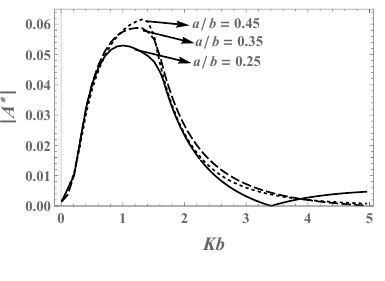
Figure 7. | A ∗ | vs Kb for a/b = 0 . 6 to a/b = 0 . 95 and c/b = 0 . 5 .